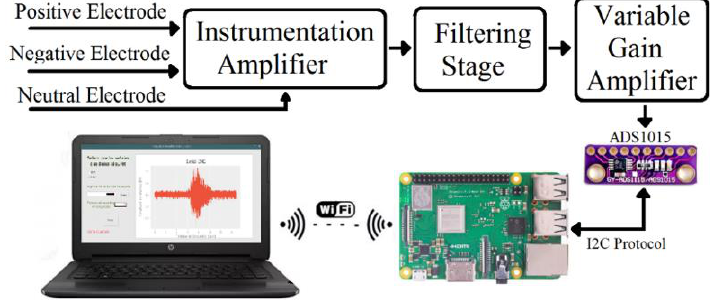
Figure 5. Surface electromyogram (EMG) measurement scheme.